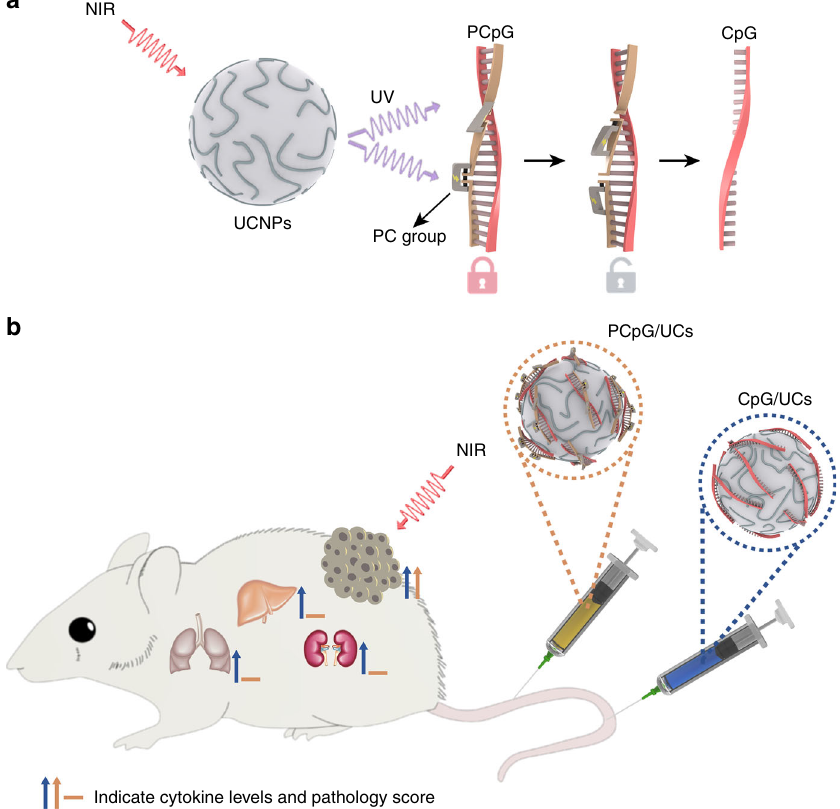
Fig. 1 Programming of photoactivatable immunodevice. a Schematic of the design of photoactivatable immunodevice through the integration of UCNPs with the UV light-responsive PCpG. UCNPs act as transducer to upconvert NIR light into UV light locally, thus liberate CpG ODN from PCpG to achieve the re fi ned temporal control on its immunoactivity. b Illustration of the photoactivatable immunodevice, PCpG/UCs, for spatially selective triggering of immunoactivity through NIR light irradiation. In contrast to traditional CpG delivery system (CpG/UCs), PCpG/UCs is amenable to personalizing the anti- tumor modality with reduced systemic